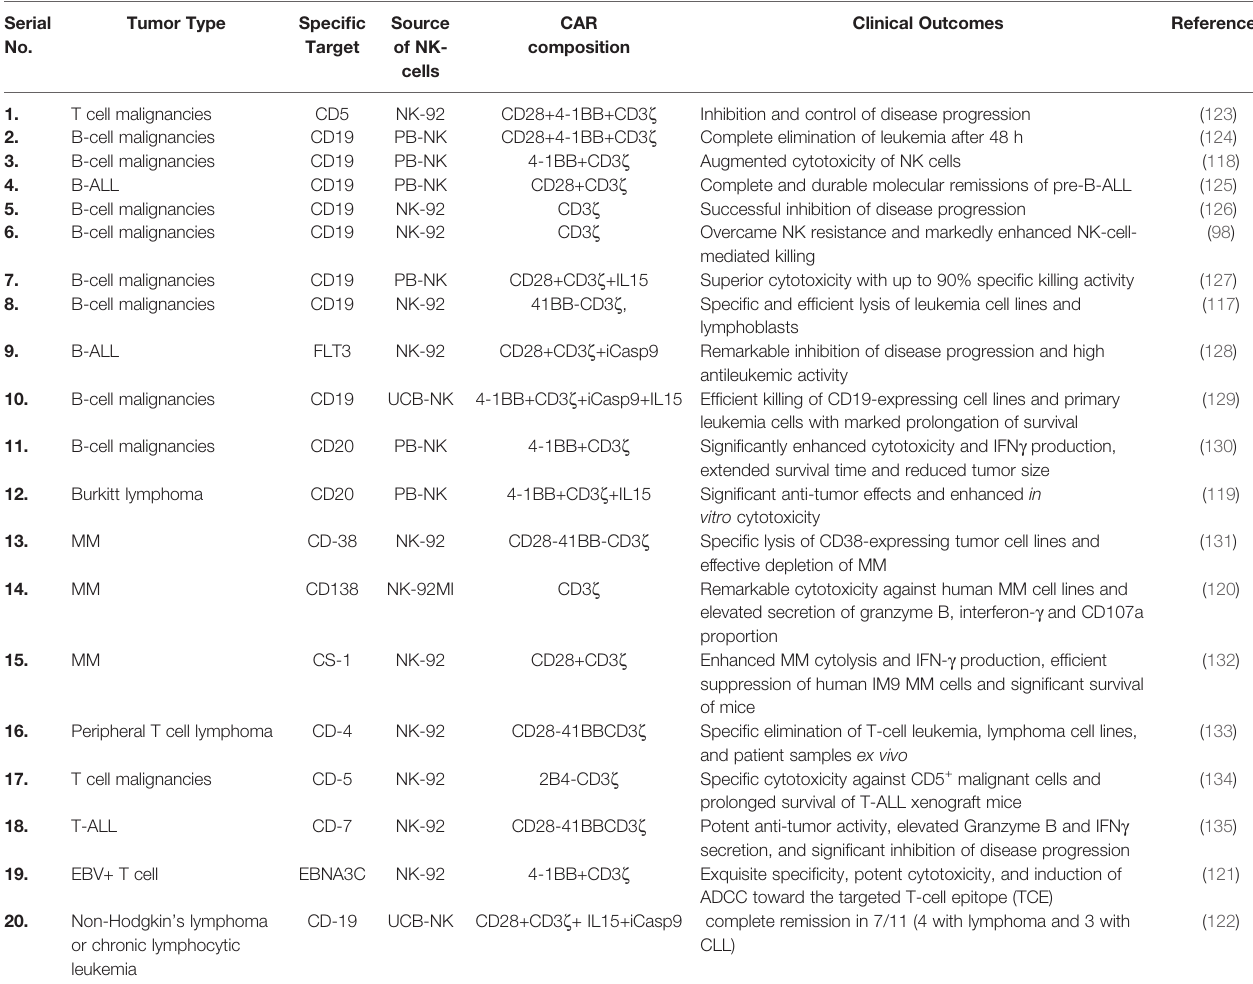
TABLE 2 | Recent preclinical studies employing CAR-NK cells against various hematological cancers. Serial